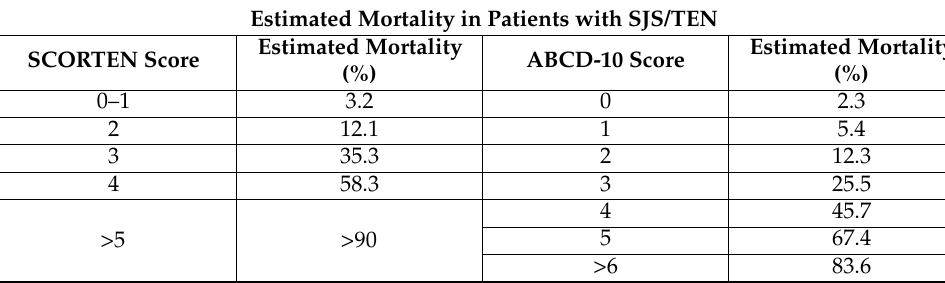
Table 6. Estimated mortality in patients with SJS/TEN. Estimated Mortality in Patients with